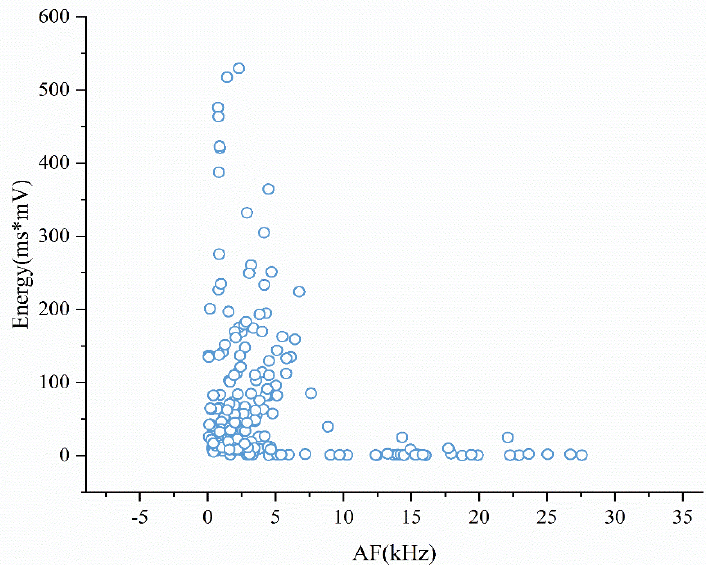
Figure 22. Average frequency-energy correlation diagram of noise signal of Yangma Island Bridge.